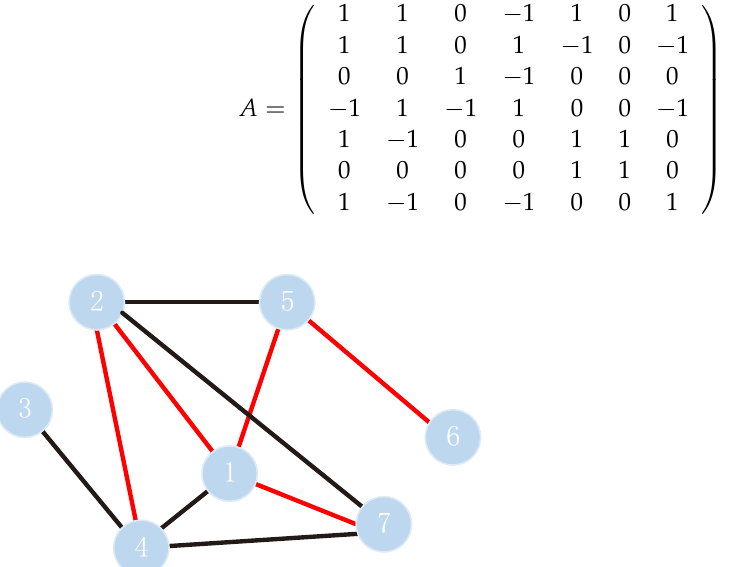
Figure 2. An example of protein–protein interaction (PPI) network. The PPI network consists of seven protein nodes and some connected